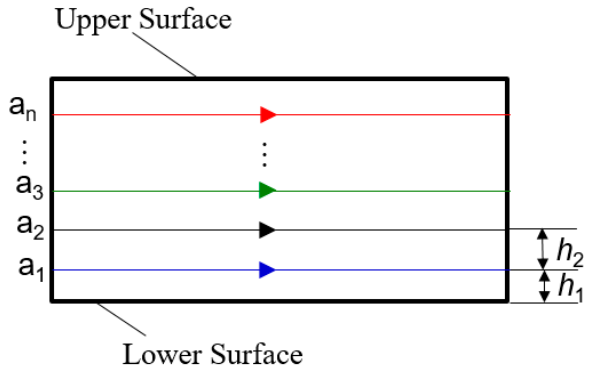
track, and h is the distance between the upper end of the flange and the lower end of the Figure 4. The circular measurement trajectory. flange distance.